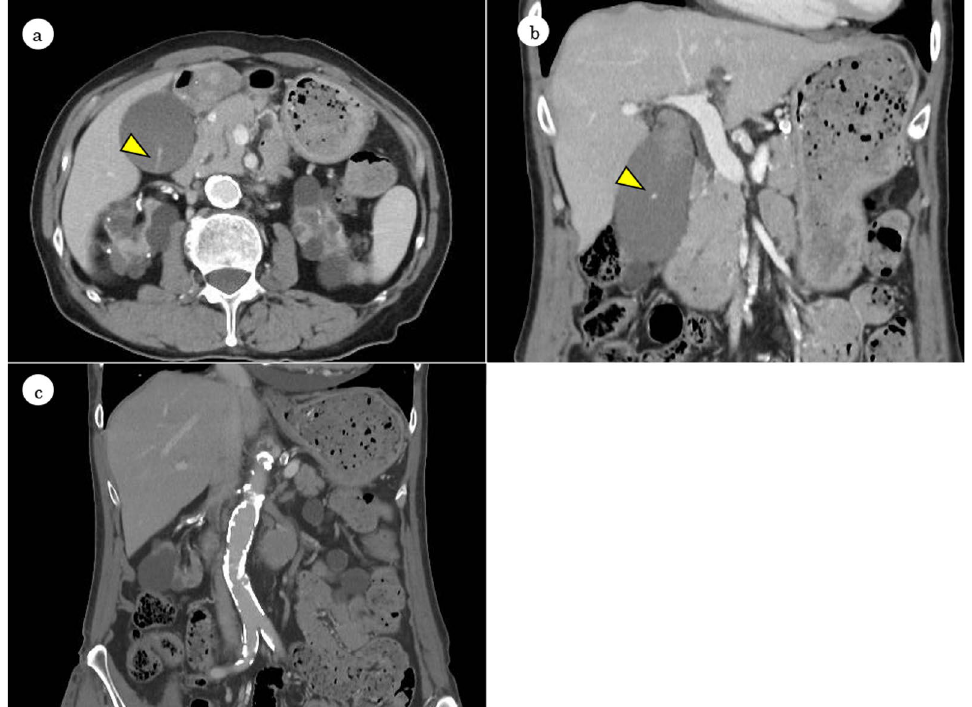
Fig. 1 Contrast‑enhanced computed tomography scans showing slightly hyperdense material and active extravasation (arrowhead) within a distended gallbladder lumen. There is no evidence of aneurysm of the cystic artery, gallstones, or ascites ( a , b ). Severe calcification is present in the aorta and the peripheral arteries ( c